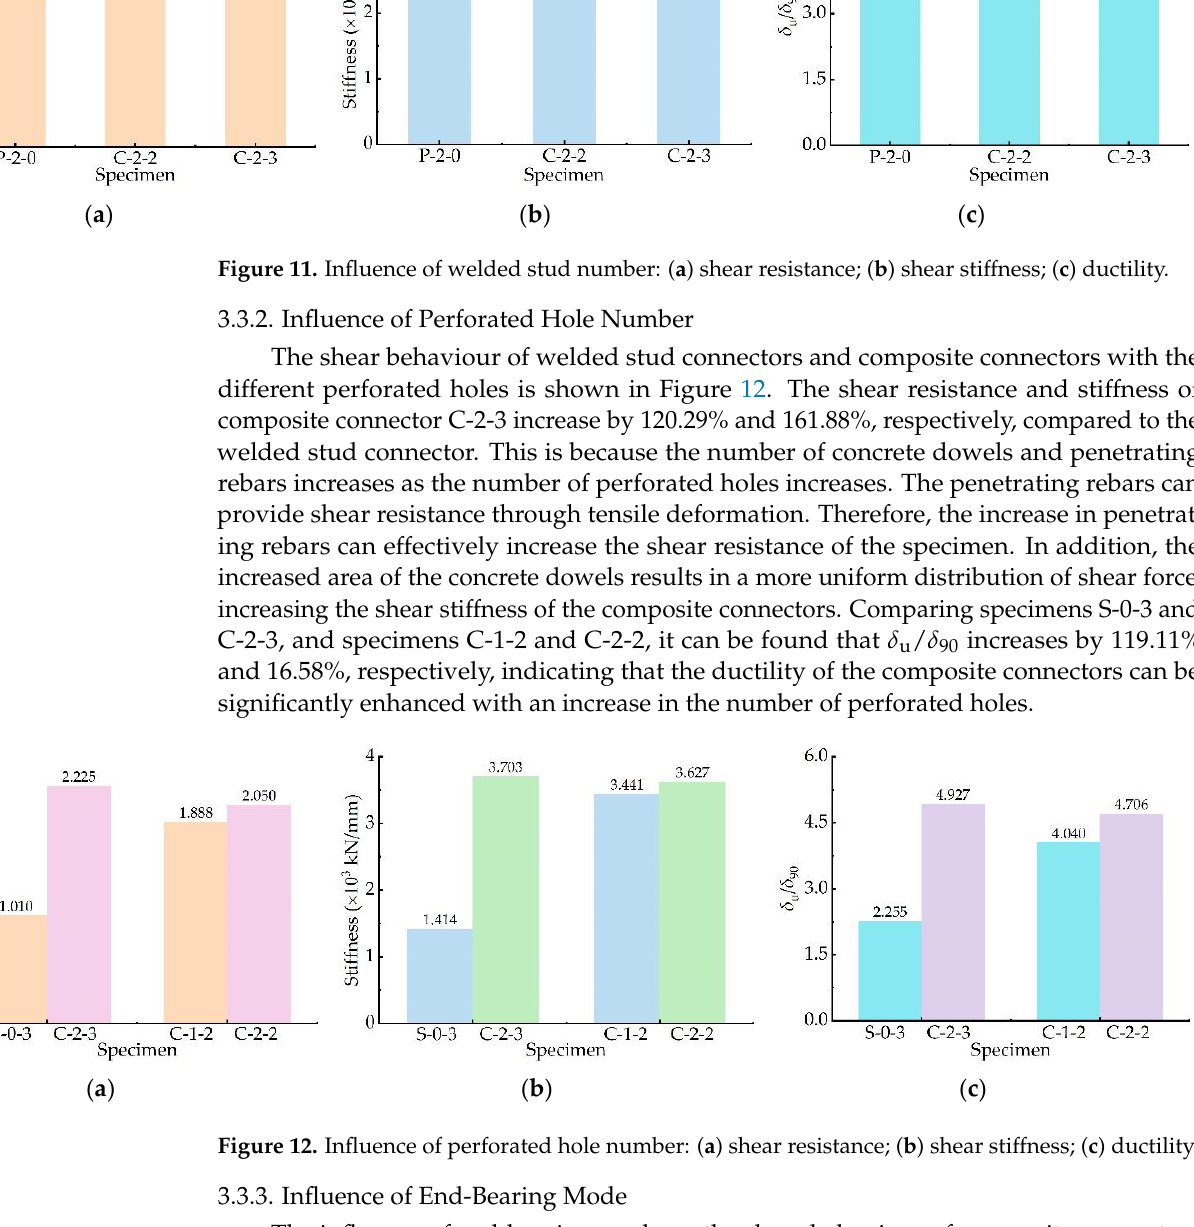
( c ) Figure 13. Influence of end-bearing mode: ( a ) shear resistance; ( b ) shear stiffness; ( c ) ductility. 4. Numerical Analysis 4.1. Finite Element Models The push-out tests were simulated using ABAQUS nonlinear finite element software, as shown in Figure 14. Different elements were attributed to each component due to the different materials used, the different stress state, and the relatively complex contact rela- tionships between the components. Concrete slabs, H-beams, perforated steel plates, pen- etrating rebars, and welded studs were simulated using C3D8R solid elements, and struc- tural rebars were simulated using T3D2 truss elements. The mesh sizes for the composite connections were 2 mm, 4 mm, 4 mm and 5 mm for the welded studs, perforated steel plates, penetrating rebars and concrete dowels, respectively. Meanwhile, to improve the